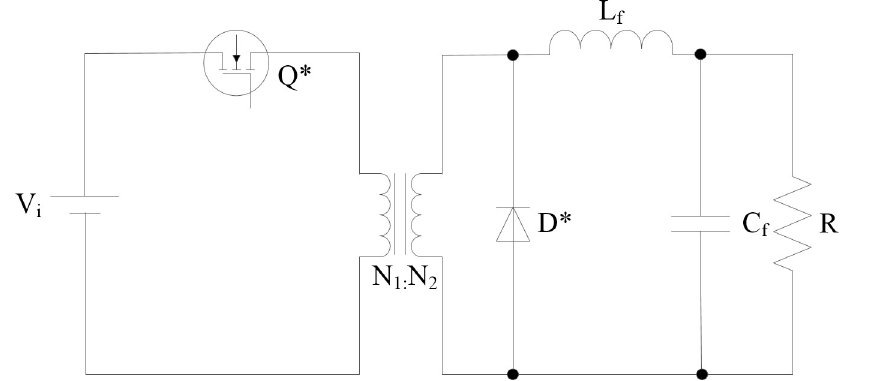
Fig 2. Buck circuit equivalent model of Full-Bridge